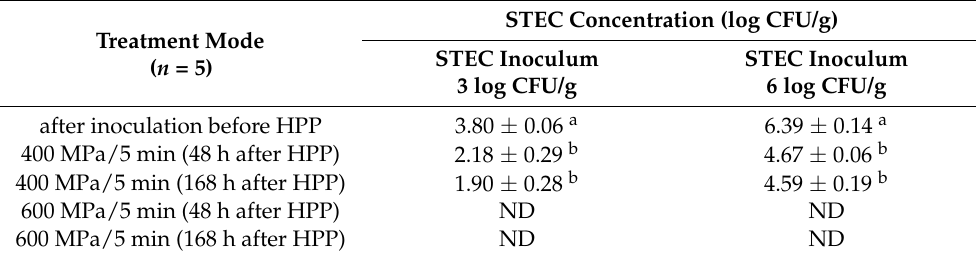
Table 2. Results for the STEC count (mean ± standard deviation) in CFU/g in the product steak tartare following artificial inoculation with a cocktail of STEC of 3 and 6 log CFU/g and following pasteurization using HPP (high-pressure processing) at a pressure of 400 and 600